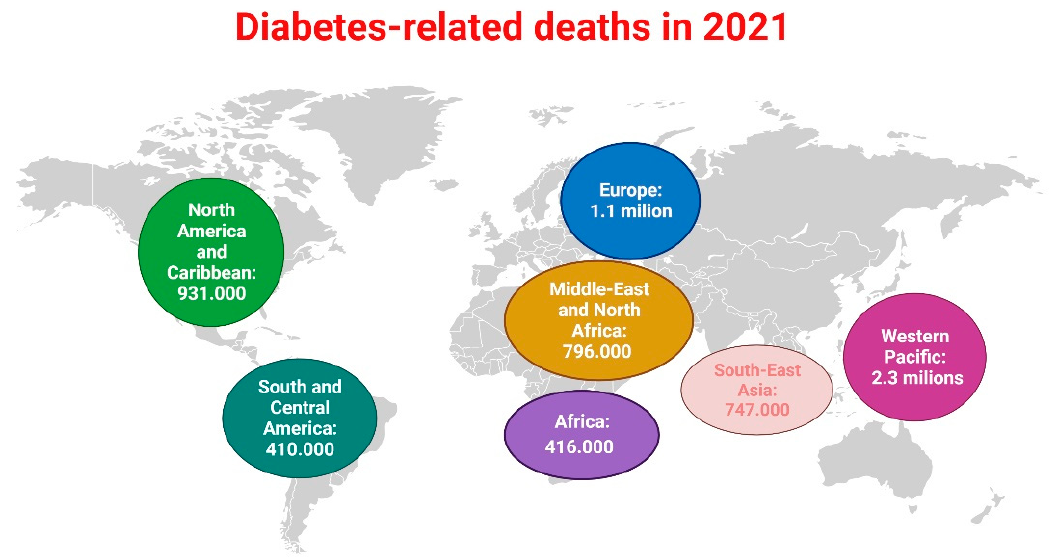
Figure 2. DM-related deaths (among 20–79 years old) in 2021. DM, diabetes mellitus. The figure is drawn with Biorender based on tabular data from reference [8].